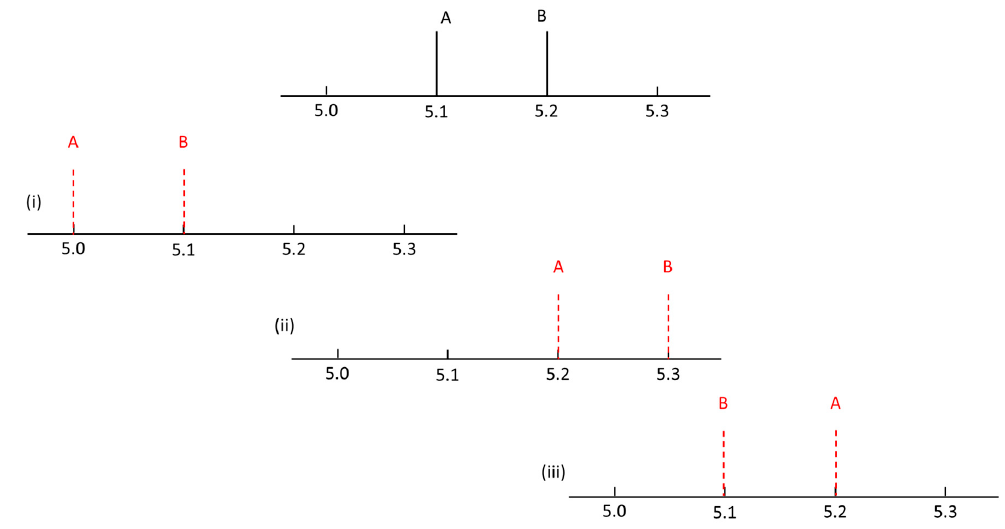
Figure 1. Schematic depiction of three chromatograms with identical retention time error, but different elution order errors (vertical solid lines in black: true retention time of analyte A and B; vertical dotted lines in red: predicted retention time of analyte A and B).